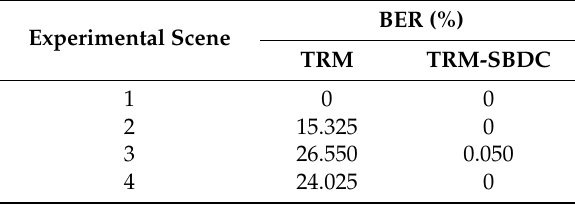
Table 4. The decoding results of different experimental scenes. Experimental Scene